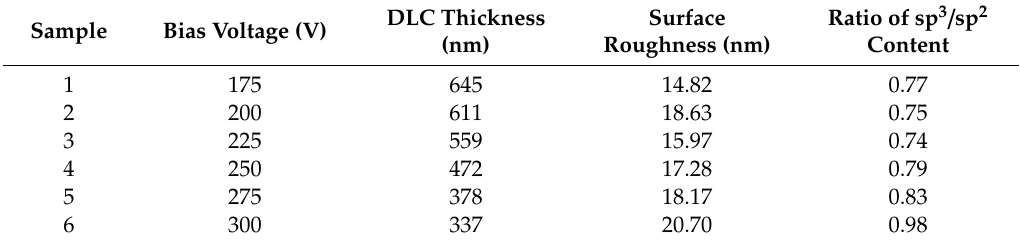
Figure 1. Schematic diagram of MC-hybrid coating system.